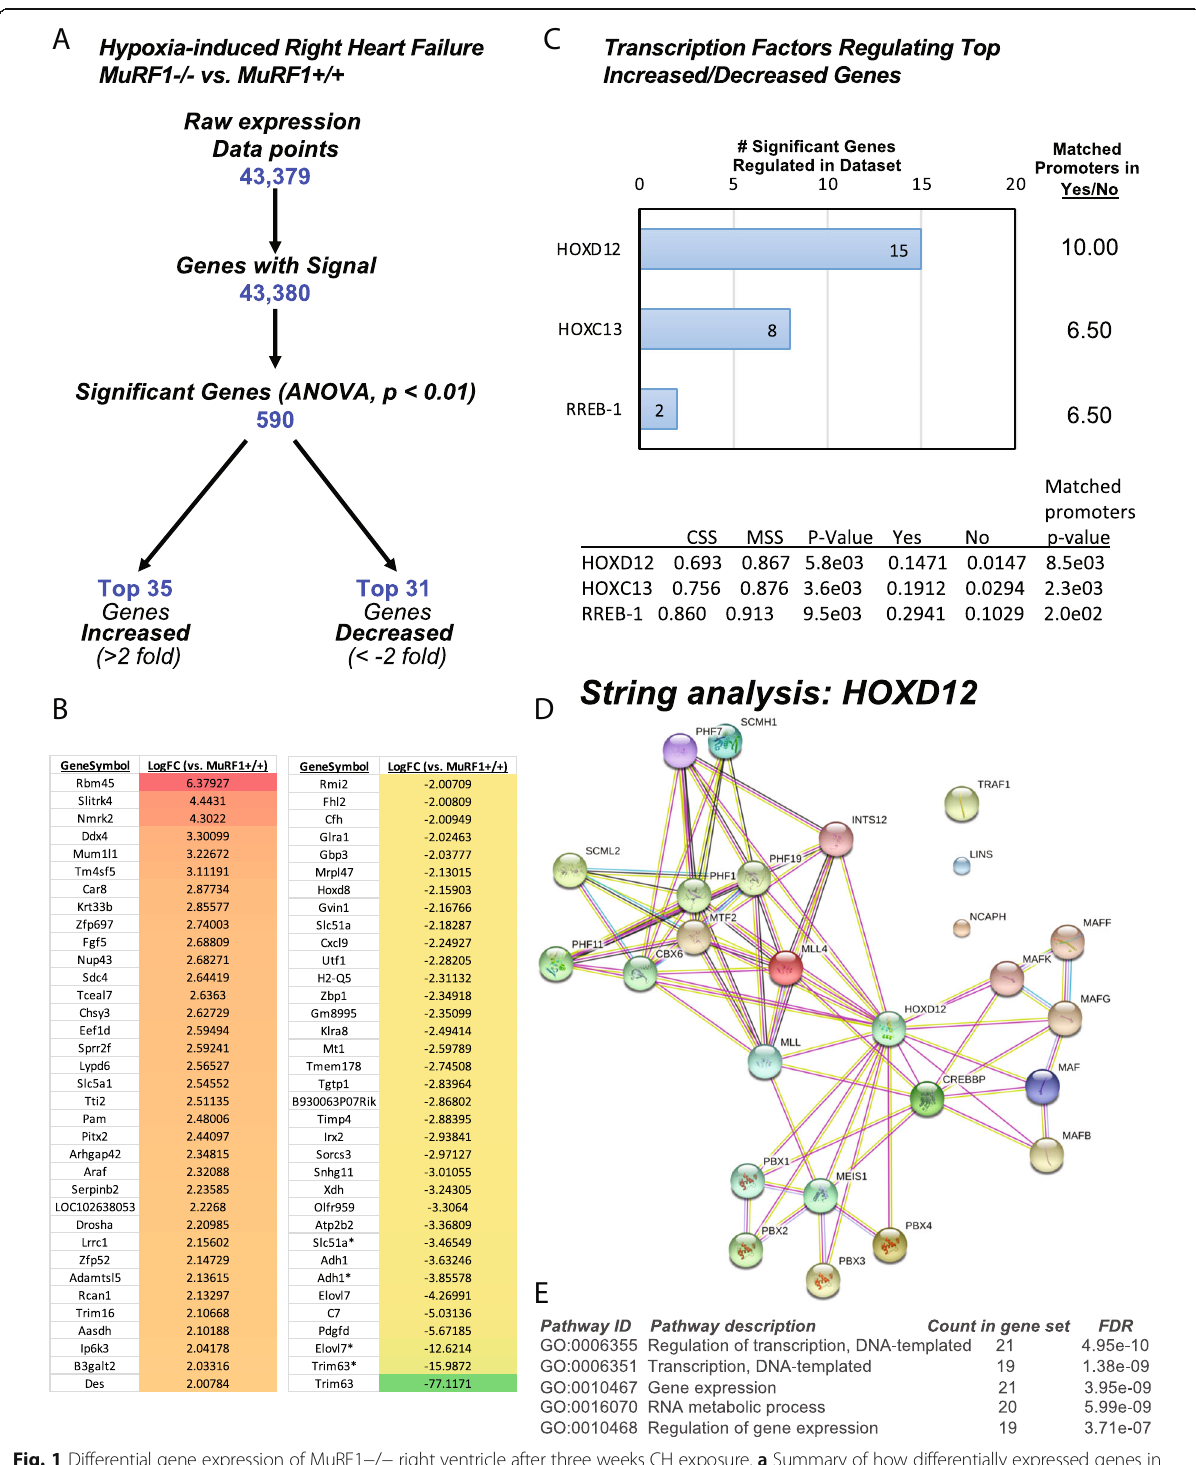
Fig. 1 Differential gene expression of MuRF1 − / − right ventricle after three weeks CH exposure. a Summary of how differentially expressed genes in hypoxia-challenged MuRF1 − / − RV tissue compared to MuRF1+/+ were identified. b Top 35 increased unique genes (>2-fold) and top 31 decreased unique genes (< − 2-fold) compared to MuRF1+/+ hearts. Asterisk (*) designates same/related sequence for duplicate gene name. c Identification of transcription factors with binding sites of top 35 increased and top 31 decreased genes using TRANSFAC® FMatch. The number of genes in dataset and enrichment (sites/sequence ratio) for each transcription factor is calculated to the right. d STRING analysis of differentially expressed genes for known interactions and e STRING analysis pathway ID statistics. MuRF1 − / − : N =5 biological replicates; MuRF1+/+: N =6 biological